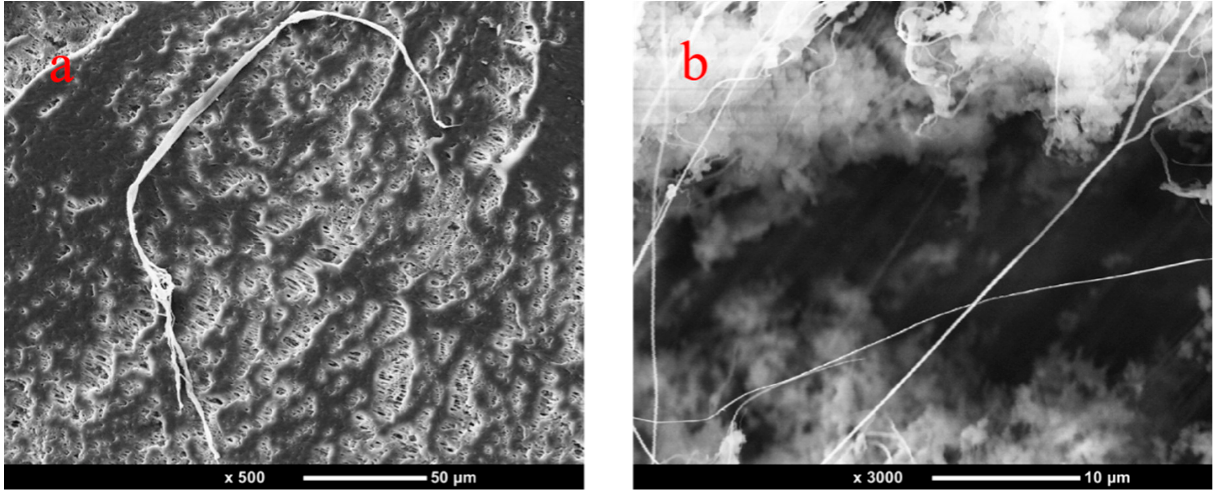
Figure 3. ( a ) SEM picture of PP/1 % PTFE after PP etched with p − xylene, ( b ) SEM picture of PP/3 % PTFE after PP etched with p − xylene.